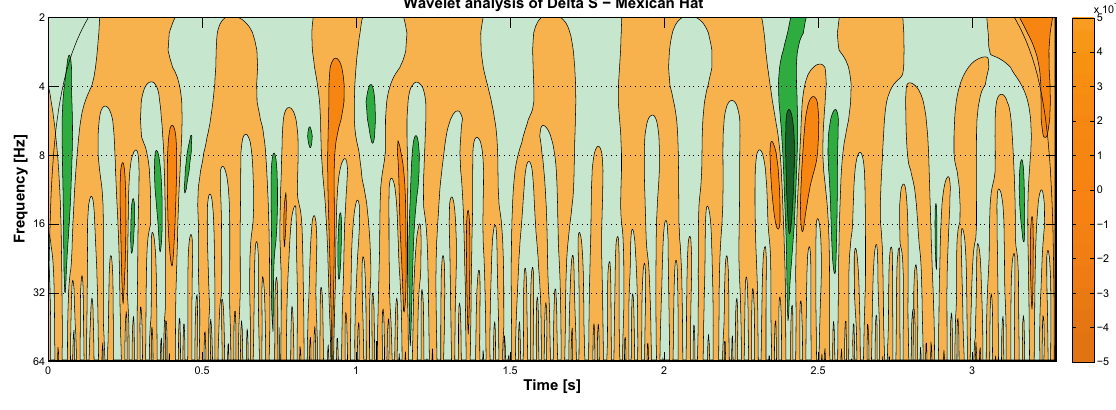
(b) Artificial sweep-ejection relative contribution to the total momentum flux in the canyon. Sweep is negative, ejection is positive. Fig. 7: Artificial time-series created by inserting sweep with true negative sign and ejection with inverse sign (now positive). Wavelet analysis of Delta S − Mexican Hat